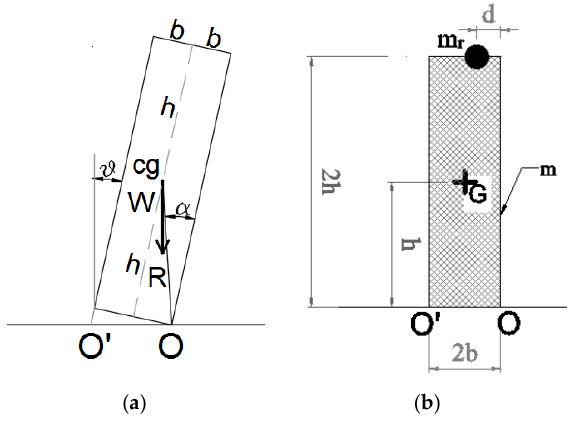
Figure 1. The rectangular free-standing rocking block of Housner’s model ( a ) and the centroid G c of the composed masonry block + the roof mass system with eccentricity d ( b ).